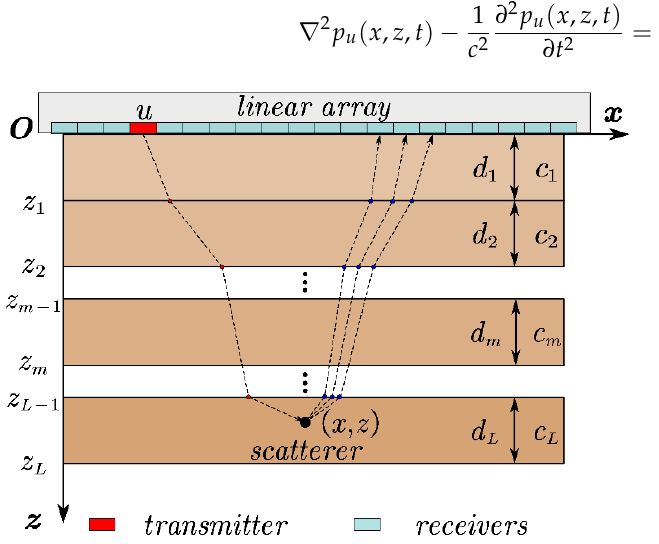
Figure 1. Multi-layered object inspected by a linear